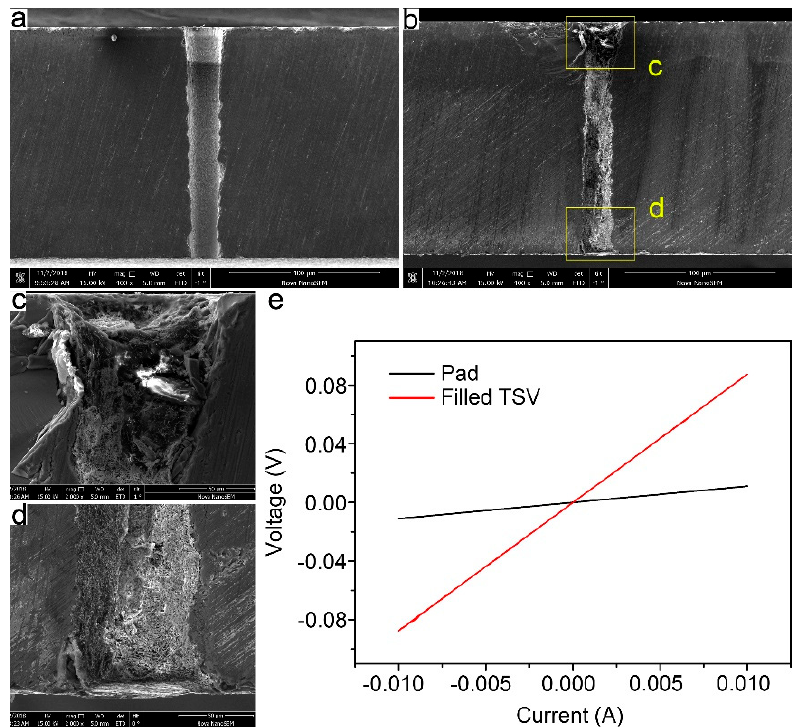
Figure 5. ( a , b ) Cross-sectional SEM images of a TSV before ( a ) and after ( b ) being filled with 30 wt% silver nanowires ECAs. ( c ) and ( d ) show the magnified images of top and bottom of the filled TSV marked with boxes in ( b ), respectively. ( e ) I-V measurement curves of a fully filled TSV with 30 wt% silver nanowires ECAs (red) and deposited Ti / Au pad (black).